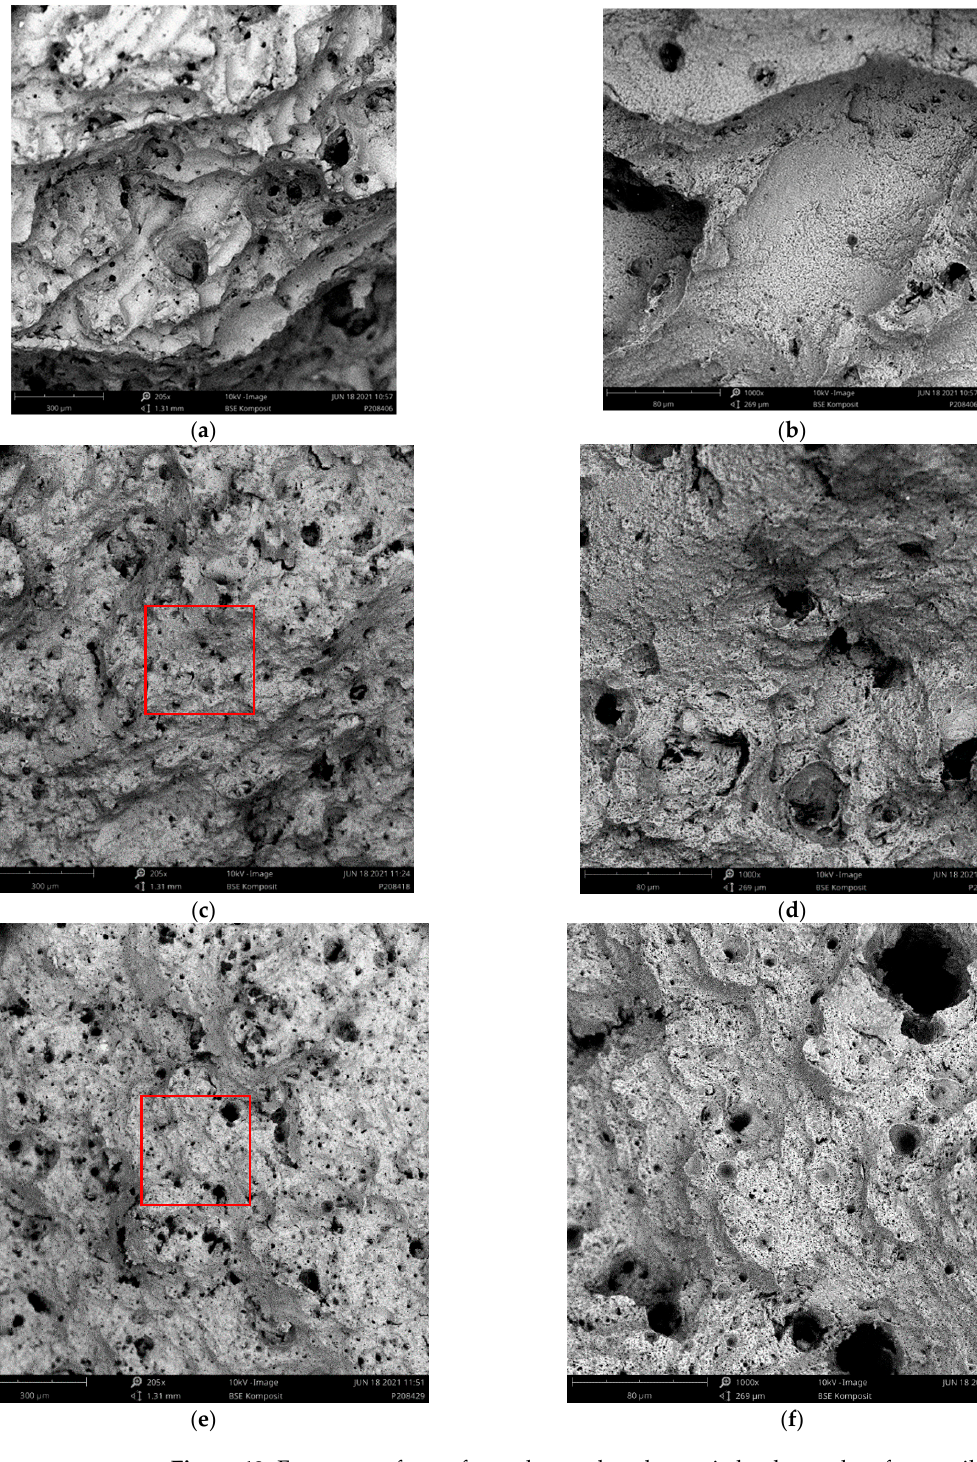
Figure 13. Fracture surfaces of samples produced at varied polar angles after tensile testing at 250 ◦ C. Left column, low magnification overview, right, increased magnification: ( a , b ) polar angle 0 ◦ , ( c , d ) polar angle 45 ◦ and ( e , f ) polar angle 90 ◦ . Readers should note that the images in Figure 11a,b have already been shown as Figure 8c,d and are repeated here for direct comparison with their counterparts with polar angles 45 ◦ and 90 ◦ . Figures highlight the differences in failure locations relative to melt pool features also visible in the metallographic sections in Figure 12, specifically when comparing Figure 13a,b to Figure 13c–f. Note that the red box in the image on the left highlights the area depicted in the magnified view on the